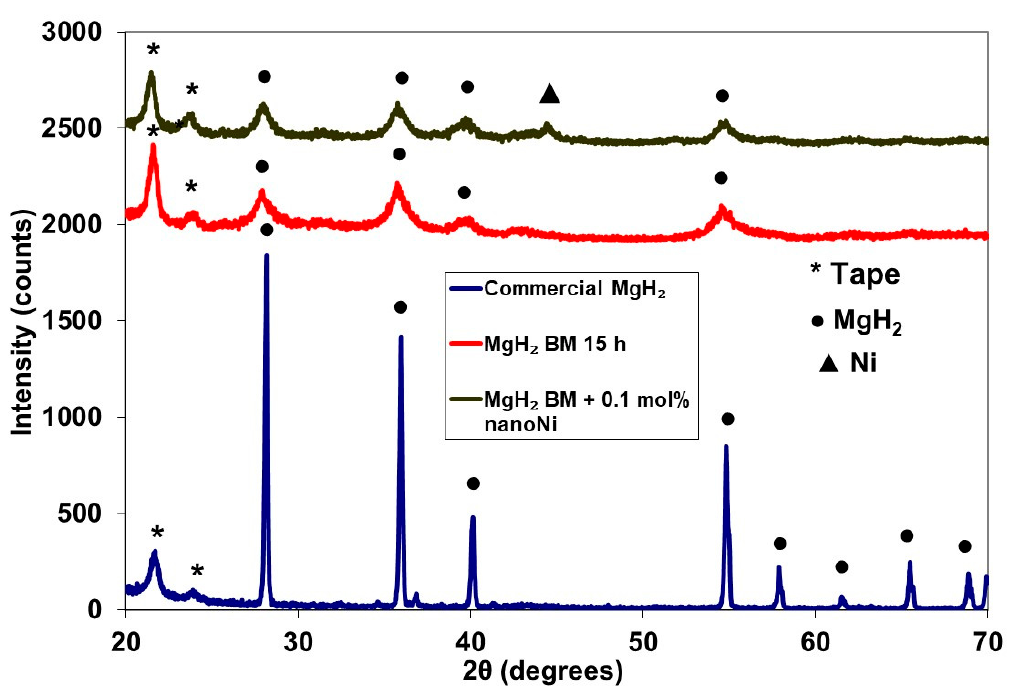
Figure 4. X-ray di ff raction spectra of bulk commercial MgH 2 , micro / nanocrystalline MgH 2 by mechanical pulverization of MgH 2 for at least 15 h and mechanically pulverized MgH 2 subsequently doped with metal nanoparticle such as nano-Ni with 0.1 mol%.